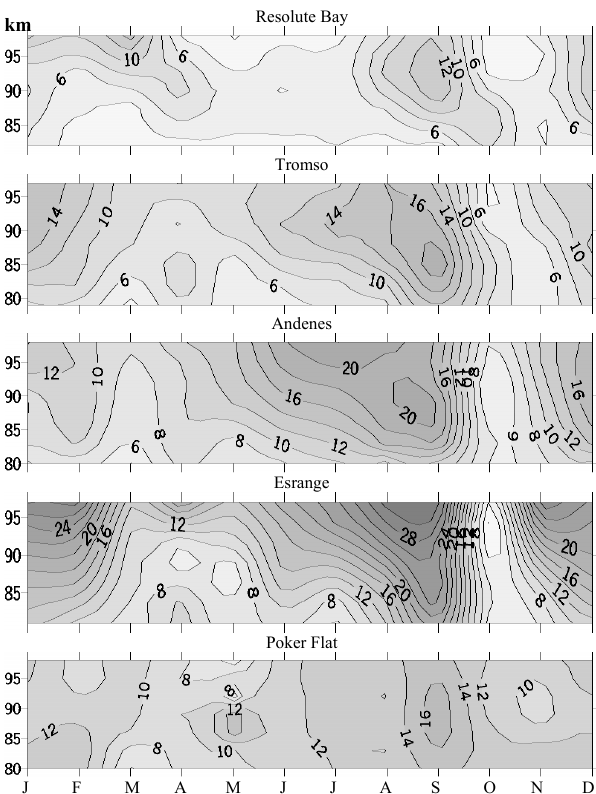
Fig. 8. As Fig. 7, but for monthly mean amplitudes of SDT, merid- ional